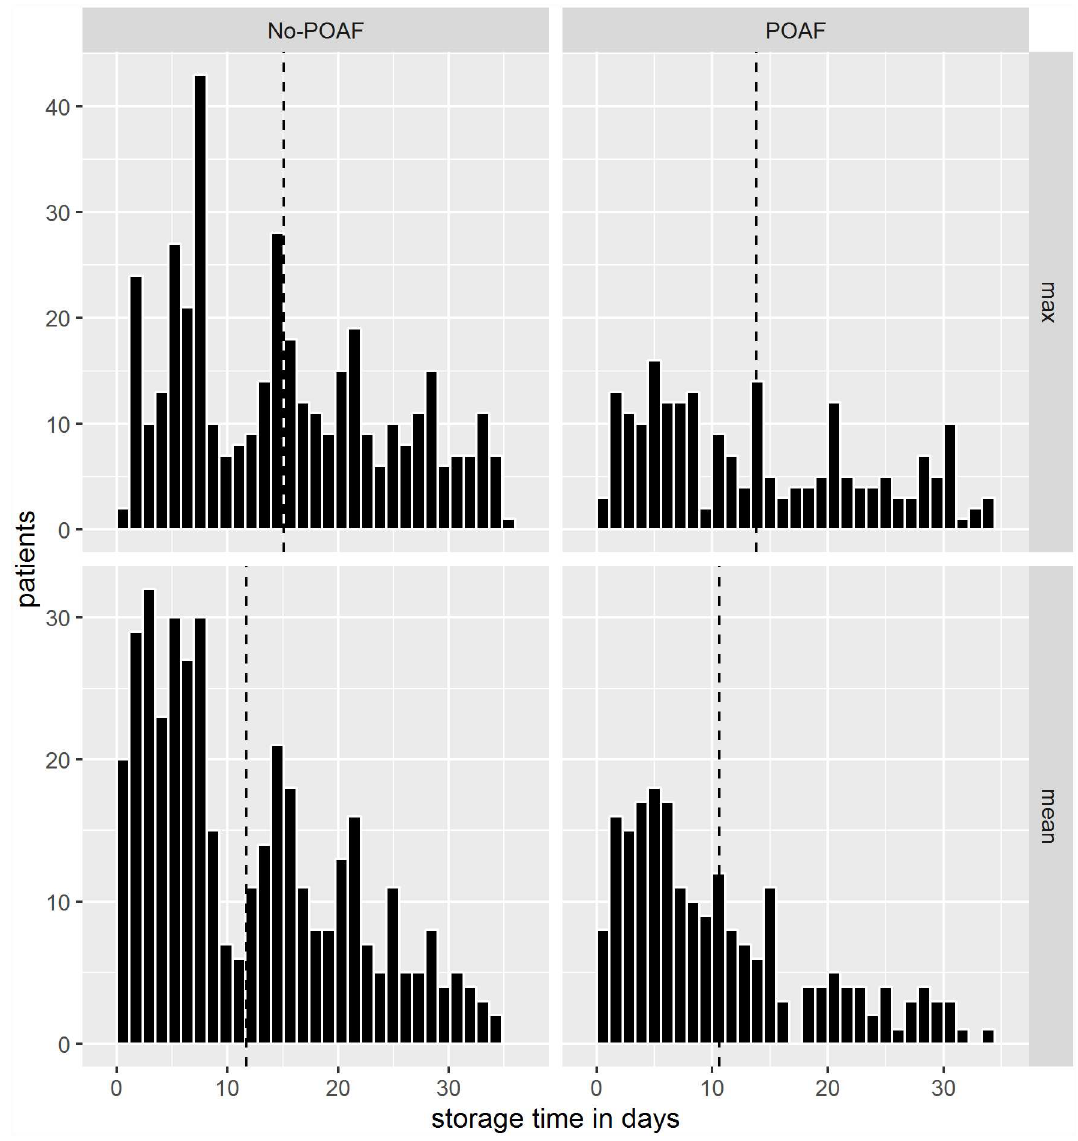
Fig 2. Distribution of maximum and mean storage time of red blood cell units transfused according to development of postoperative atrial fibrillation. Dashedlines represent the averagestorage time.